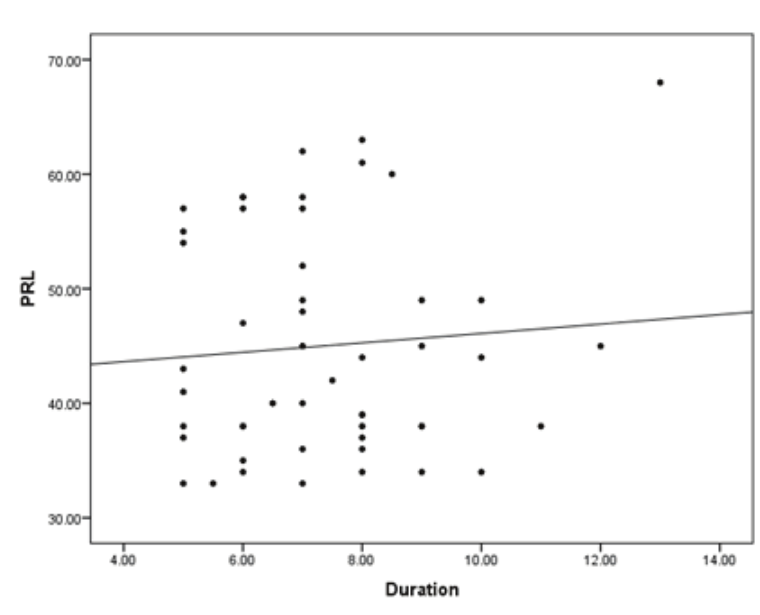
Figure 6 : Correlation of duration with PRL in case group ( R = 0.079, P = 0.587).